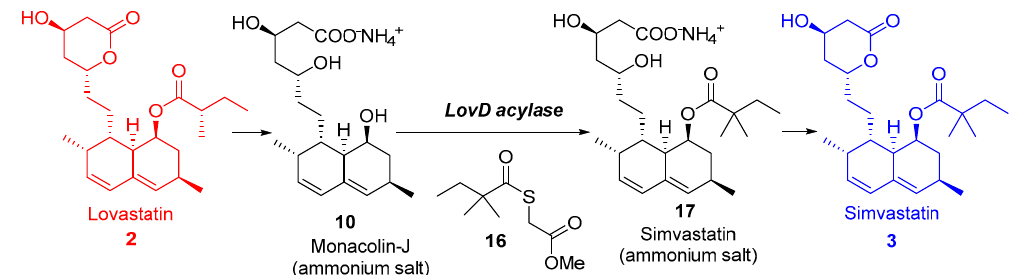
Figure 4. Biocatalyzed transformations of lovastatin 2 into simvastatin 3 .